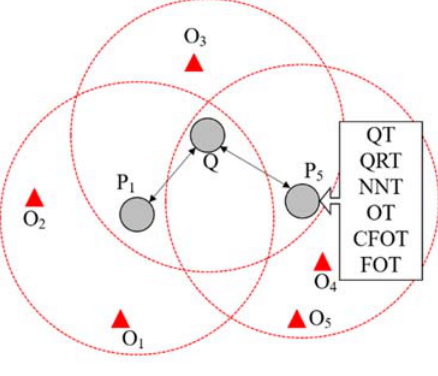
Figure 3. Tables managed by each node.